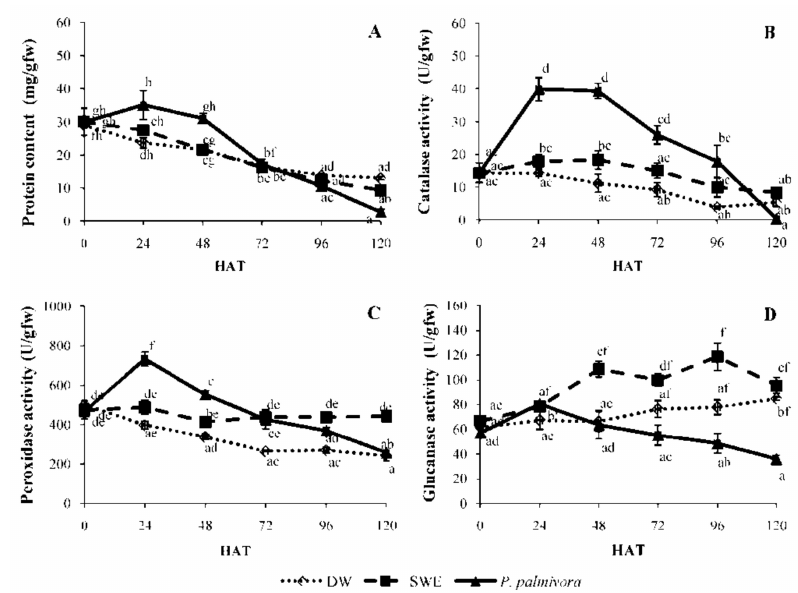
Figure 4. Protein content ( A ), catalase (CAT) activity ( B ), peroxidase (POD) activity ( C ), and β -1,3-glucanase (GLU) activity ( D ) in rubber tree leaves treated with 0.25 mg / mL SWE, 1x105 zoospores / mL P. palmivora and distilled water at 0, 24, 48, 72, 96 and 120 h after treatment (HAT). Data were presented as mean ± S.E. (n = 4). Statistical analysis was performed using a one-way ANOVA, taking p < 0.05. The letters indicate the significant differences among time points.